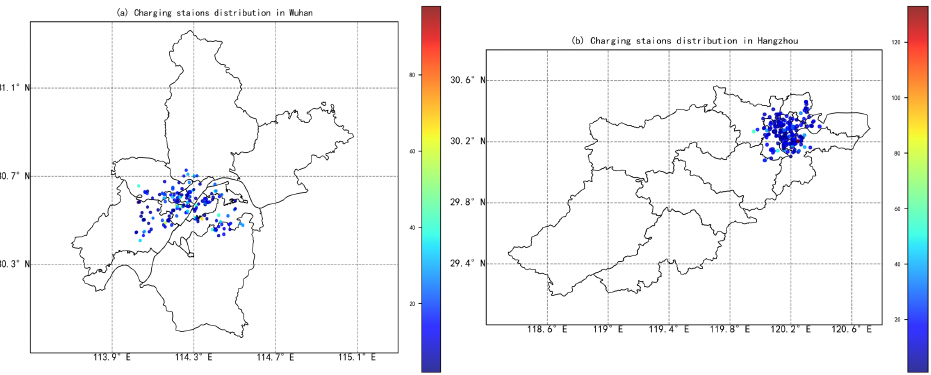
Figure 2. Distribution of NEV charging stations in urban areas. ( a ) Distribution of NEV charg- ing stations in urban areas of Wuhan. ( b ) Distribution of NEV charging stations in urban areas of